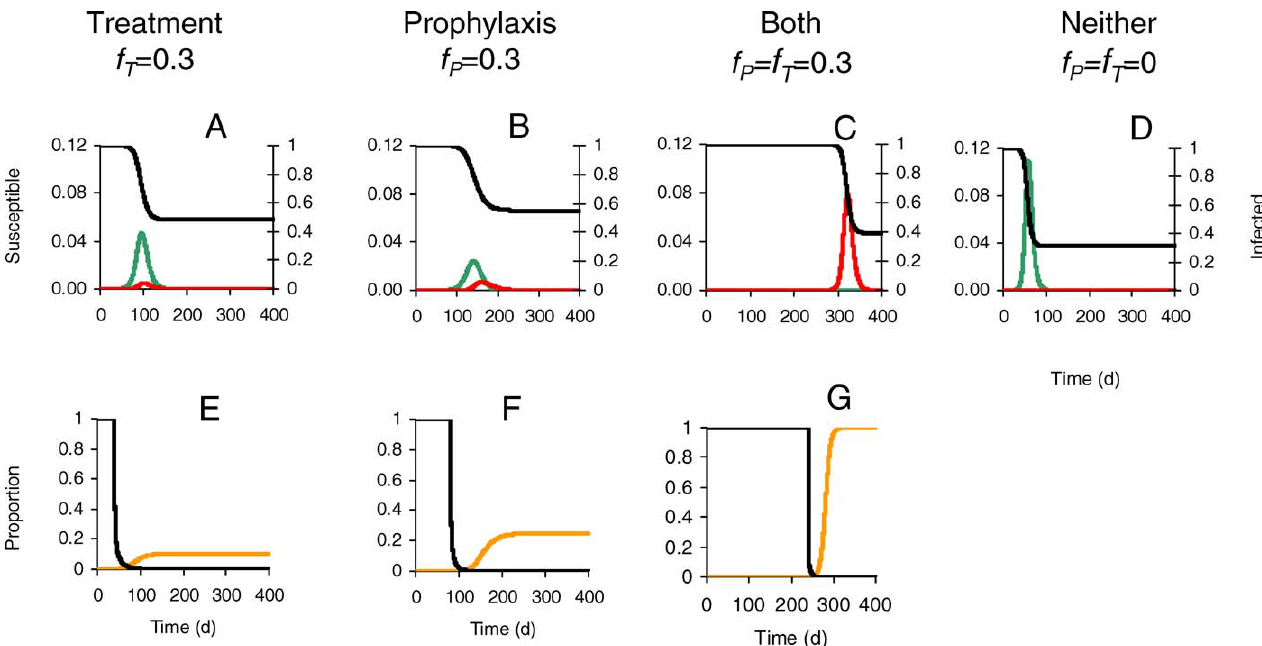
Figure 2. Impact of Treatment, Prophylaxis, Both, or Neither on the Dynamics of Resistant and Sensitive Infections (A and B) Either treatment of 30% of infected hosts (A) or prophylaxis of 30% of contacts (B) reduces transmission of a sensitive strain (green) and leads to selection of a resistant strain (red), with somewhat more resistance due to prophylaxis than treatment, although the risk that resistance will emerge is assumed to be 0.2% for treatment and 0.02% for prophylaxis. Proportions of the entire population infected with either strain are read on the left y -axis. Black curves (right y -axis) indicate the proportion of the population uninfected. (C and D) Treatment of 30% and prophylaxis of 30% (C) selects most strongly for resistance, because treatment generates resistant strains early on, and these strains are amplified by prophylaxis. (D) shows the impact of neither treatment nor prophylaxis. (E–G) These contrasting effects are apparent in following the cumulative proportion of resistant infections (black lines), which rises earlier with treatment (E), but persists and reaches higher levels with prophylaxis (F). The orange curves show the proportion of all new resistant infections attributable to de novo resistance as opposed to transmission of a resistant strain; the contribution of de-novo resistance is highest early, but rapidly declines. Graph (G) shows the impact of both treatment and